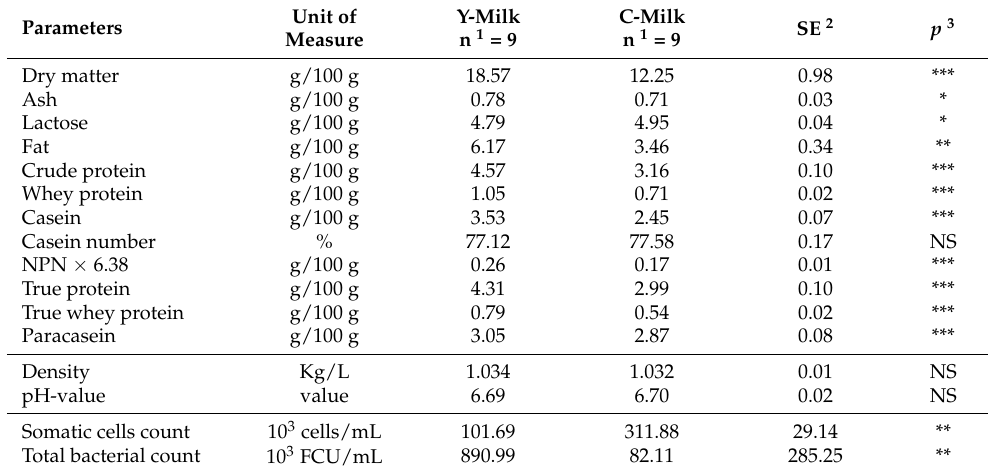
somatic cells and total bacteria for yak ( Bos grunniens , Y-milk) and cow ( Bos taurus , C-milk) milk.